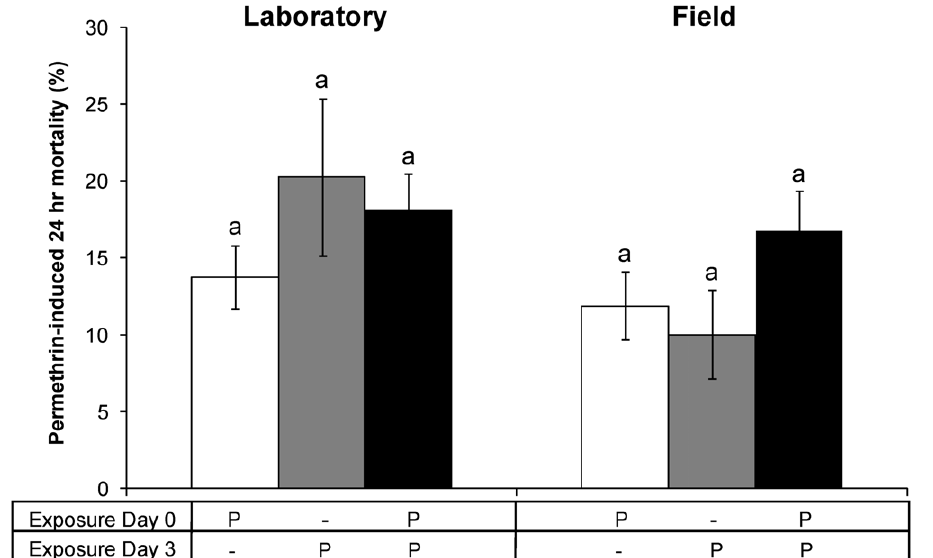
Figure 2. Permethrin sensitivity. Mean ( 6 SEM) proportional mortality of uninfected insecticide-resistant mosquitoes from the laboratory (left) and field population (right) 24 hrs after permethrin-exposure. White bars represent permethrin-induced mortality of 3-day old mosquitoes exposed once on day 0. Grey bars show mortality of 6-day old mosquitoes exposed once on day 3. Black bars show permethrin-induced mortality after a second exposure on day 3 of 6-day old mosquitoes that had survived a first exposure on day 0. From left to right, data depict 10, 5, 5, 8, 4, and 4 replicate groups of 28 females, with significant differences in group means indicated by non-corresponding letters.